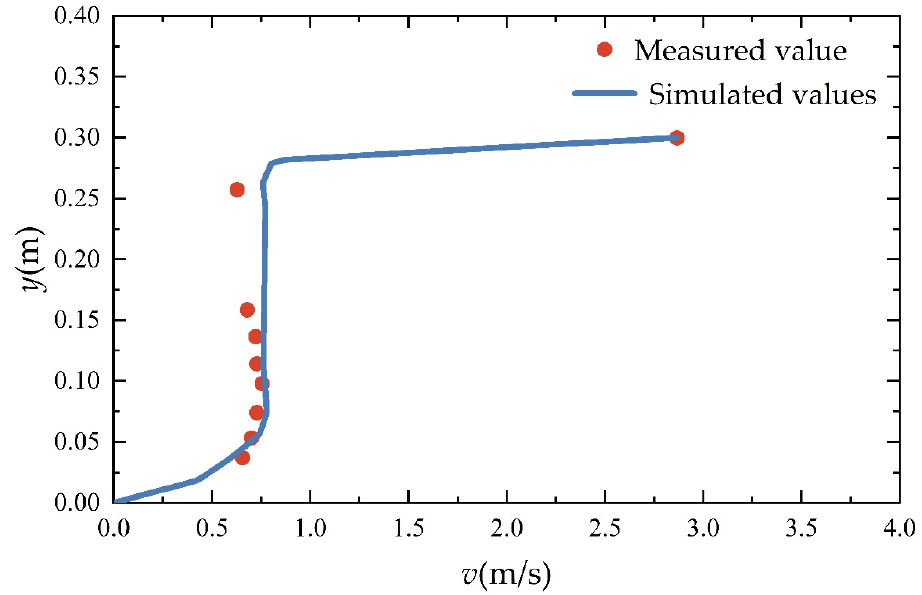
Figure 3. Comparison of simulation and test results.